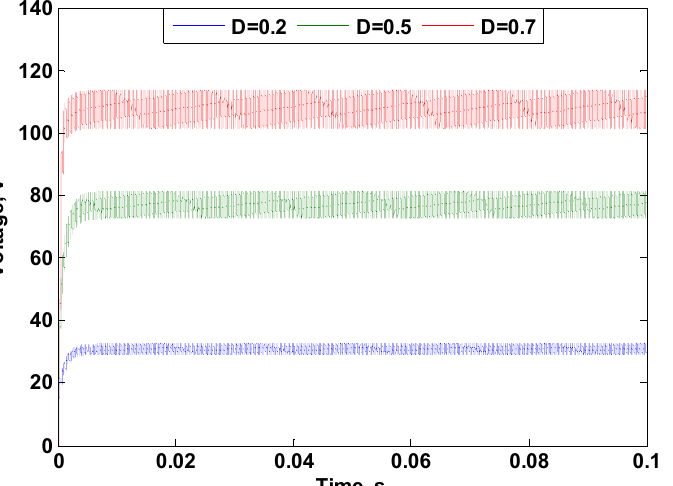
Figure 32. Voltage at the terminals of the first-stage capacitor at the same adopted duty ratios in Figure 31.